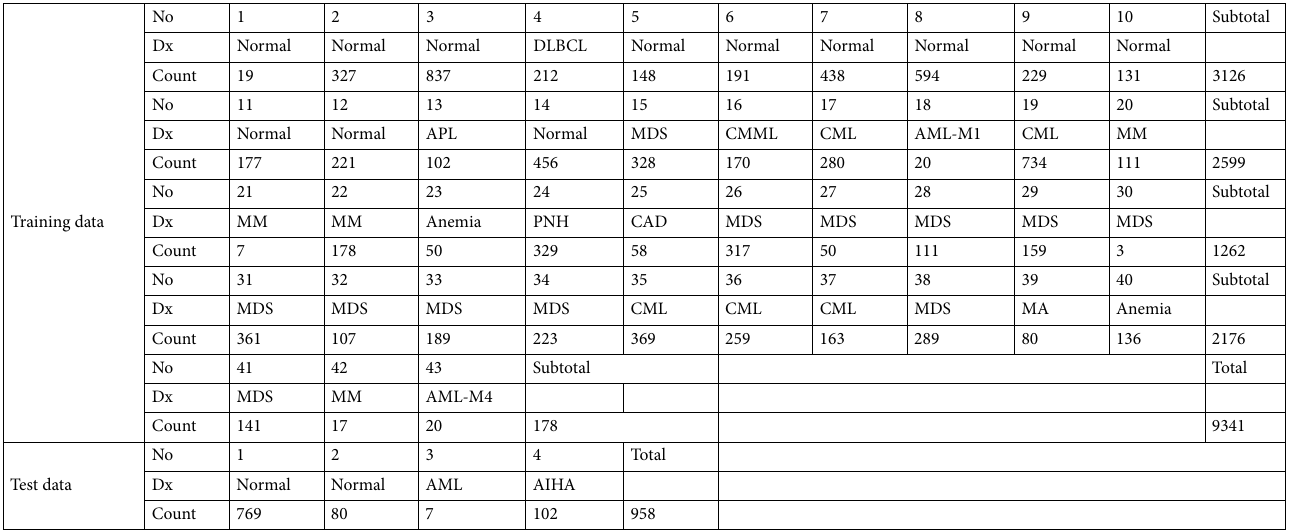
Table 4. Diagnosis and number of captured images for each of the 47 specimens. Dx, Diagnosis; DLBCL, diffuse large B-cell lymphoma; APL, acute promyelocytic leukemia (FAB-M3); MDS,